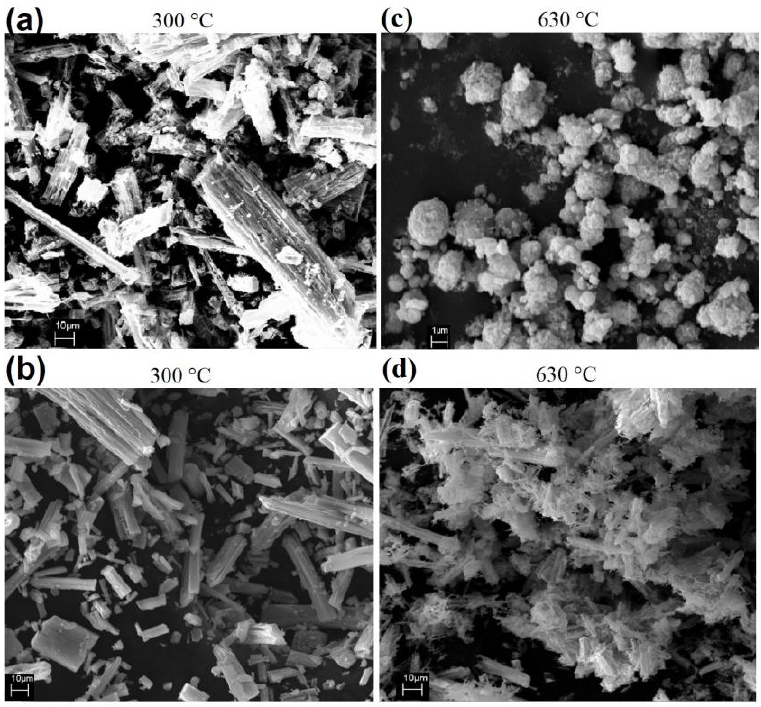
Figure 9. The SEM pictures of the decomposition products formed from compound 1 at 300 and 630 °C: ( a , c ) in air, and ( b , d ) in He atmosphere). 630 ◦ C: ( a , c ) in air, and ( b , d ) in He